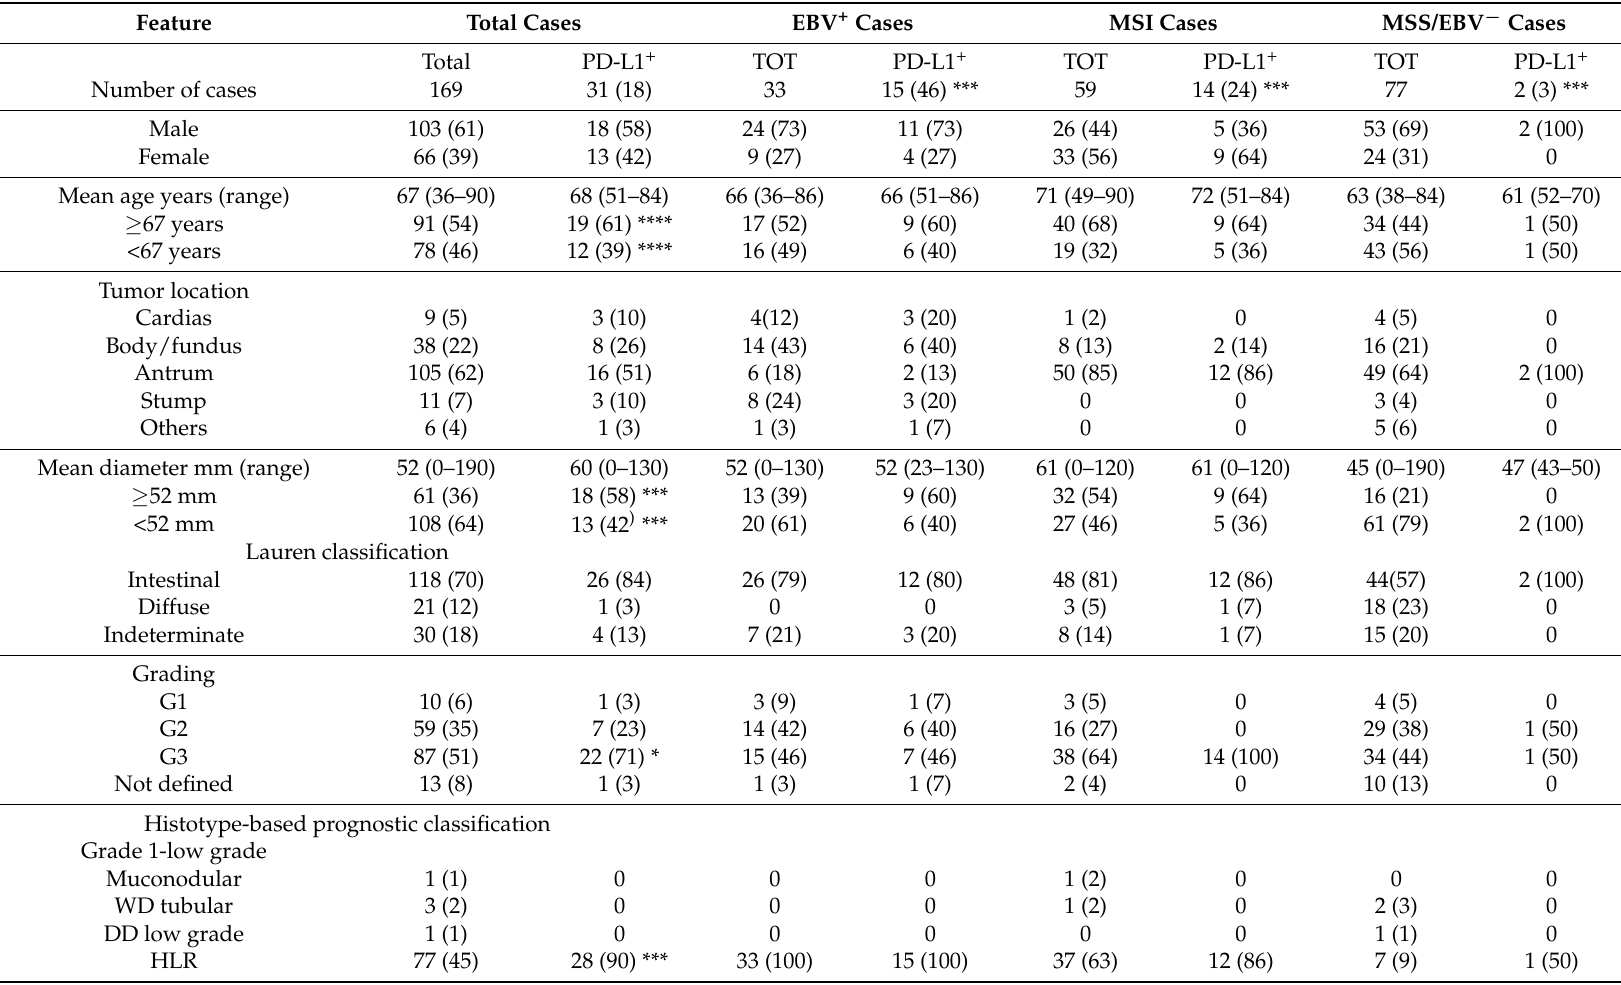
Table 1. Correlation between programmed cell death-ligand 1 (PD-L1) expression in tumor cells and clinic-pathological